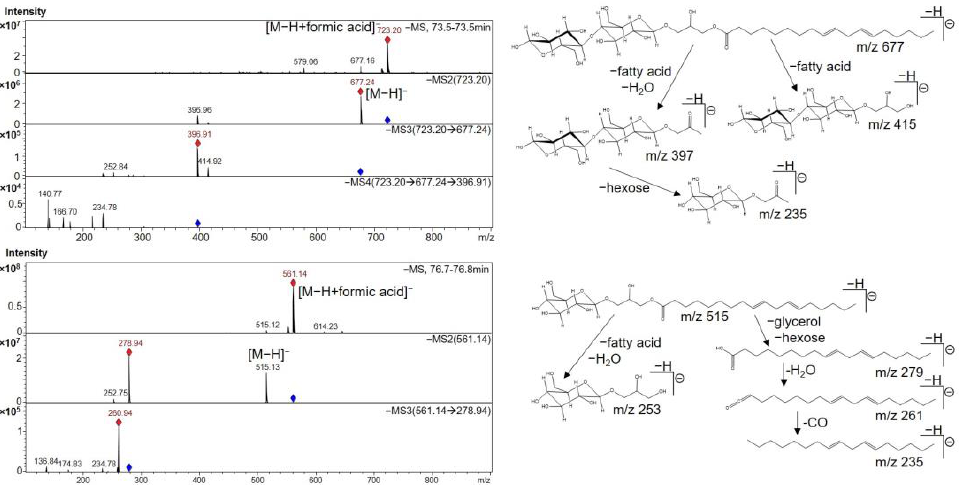
Figure 5. MS n spectra of two glyceroglycolipids (compounds 38 and 41 ) and postulated fragmenta- tion pathways.